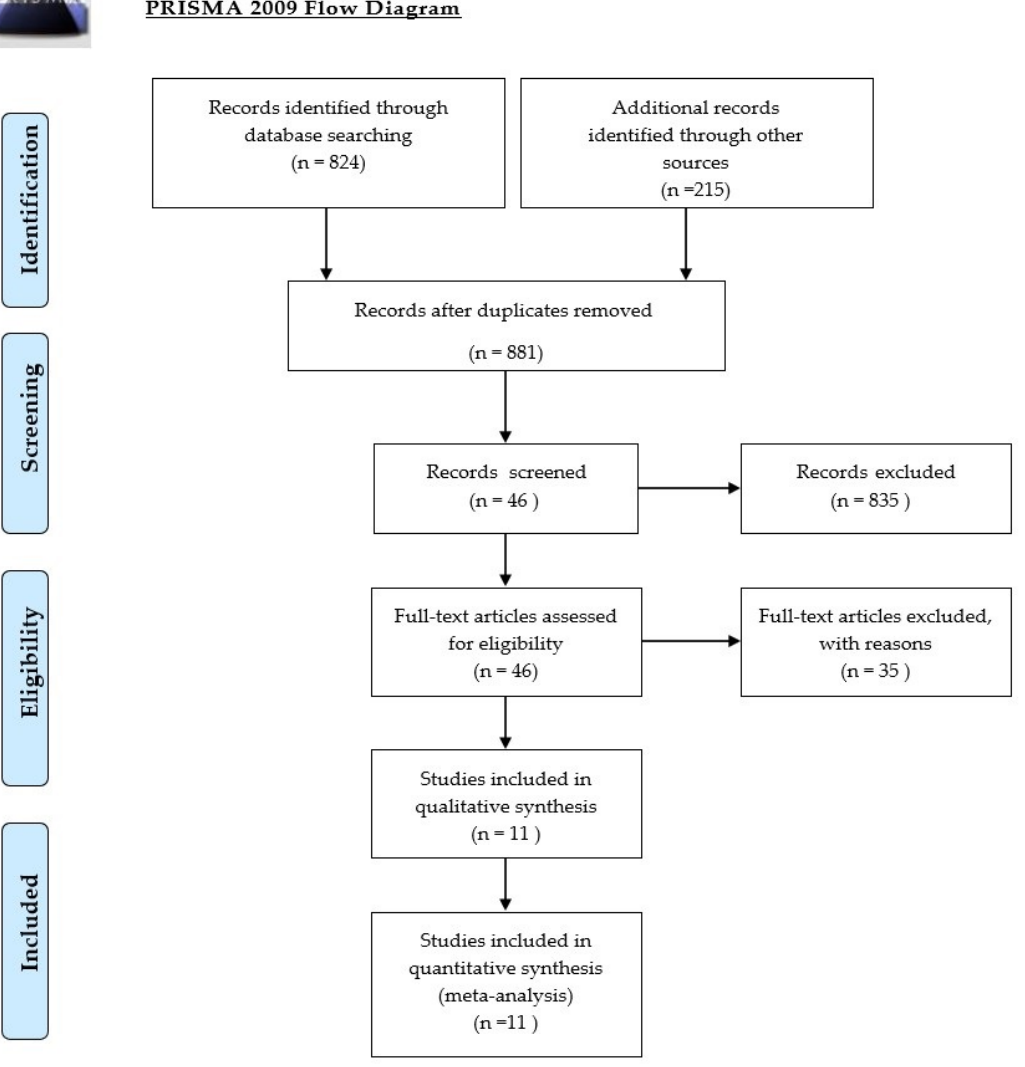
Figure 3. Flow diagram (for the selection of review articles).